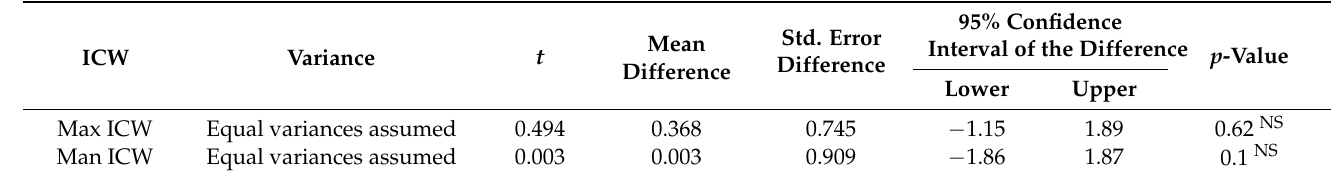
Table 5. The mean difference between two mean using independent sample-t-test for the maxillary and mandibular inter-canine width (ICW).